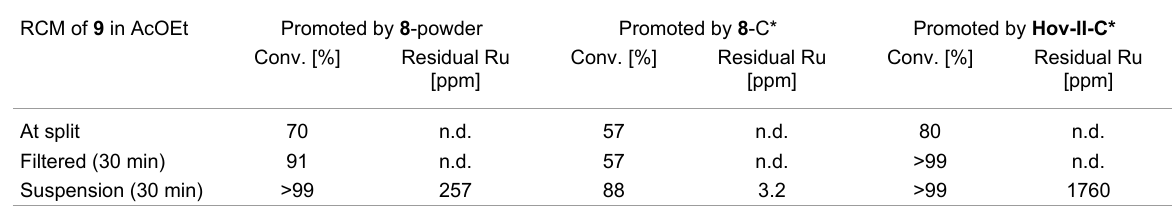
RCM of 9 in AcOEt Promoted by 8 -powder